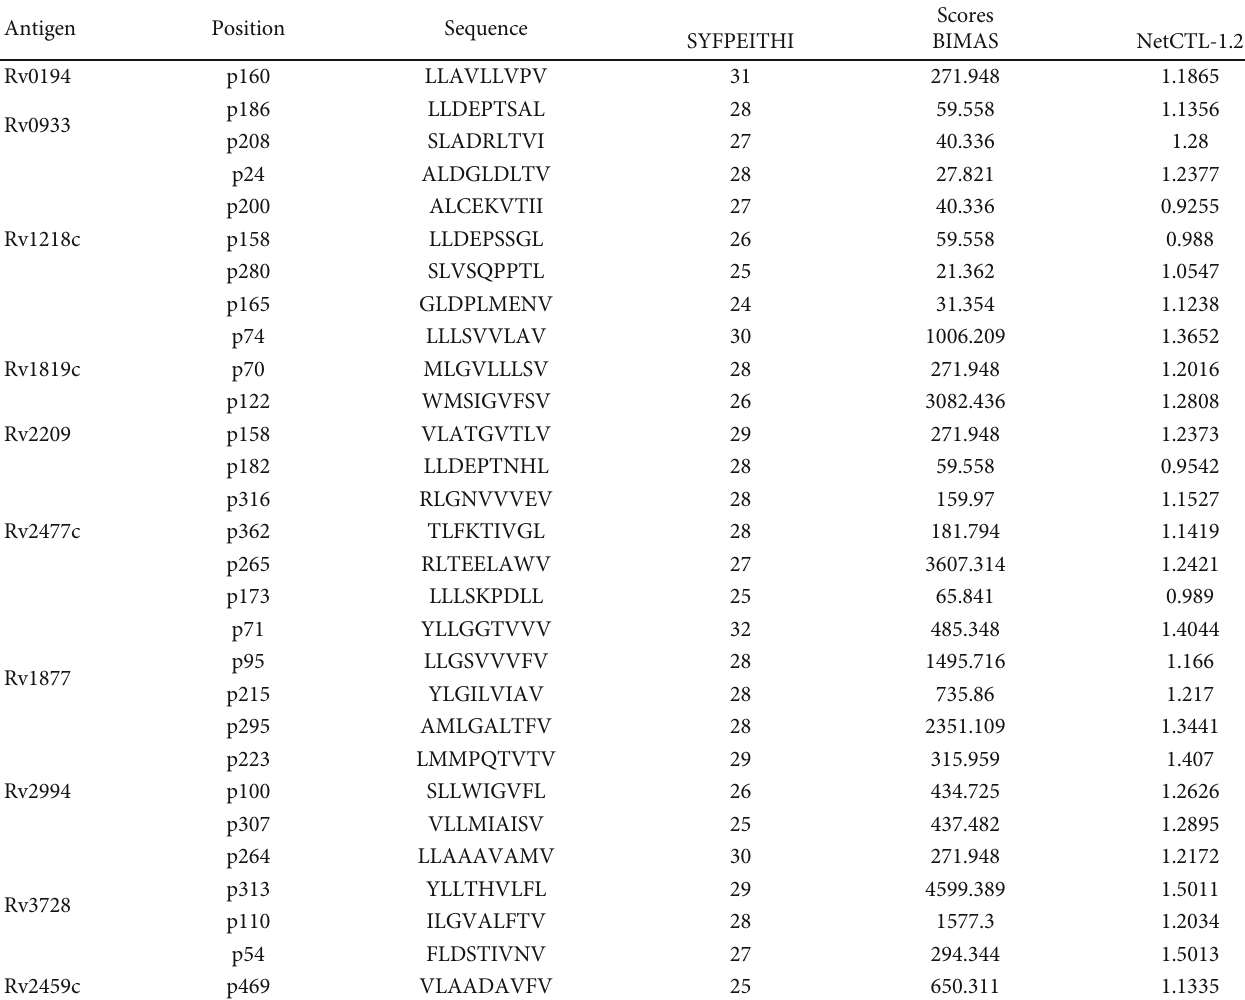
Table 1: Prediction scores of HLA-A2-restricted peptides derived from e ffl ux pump